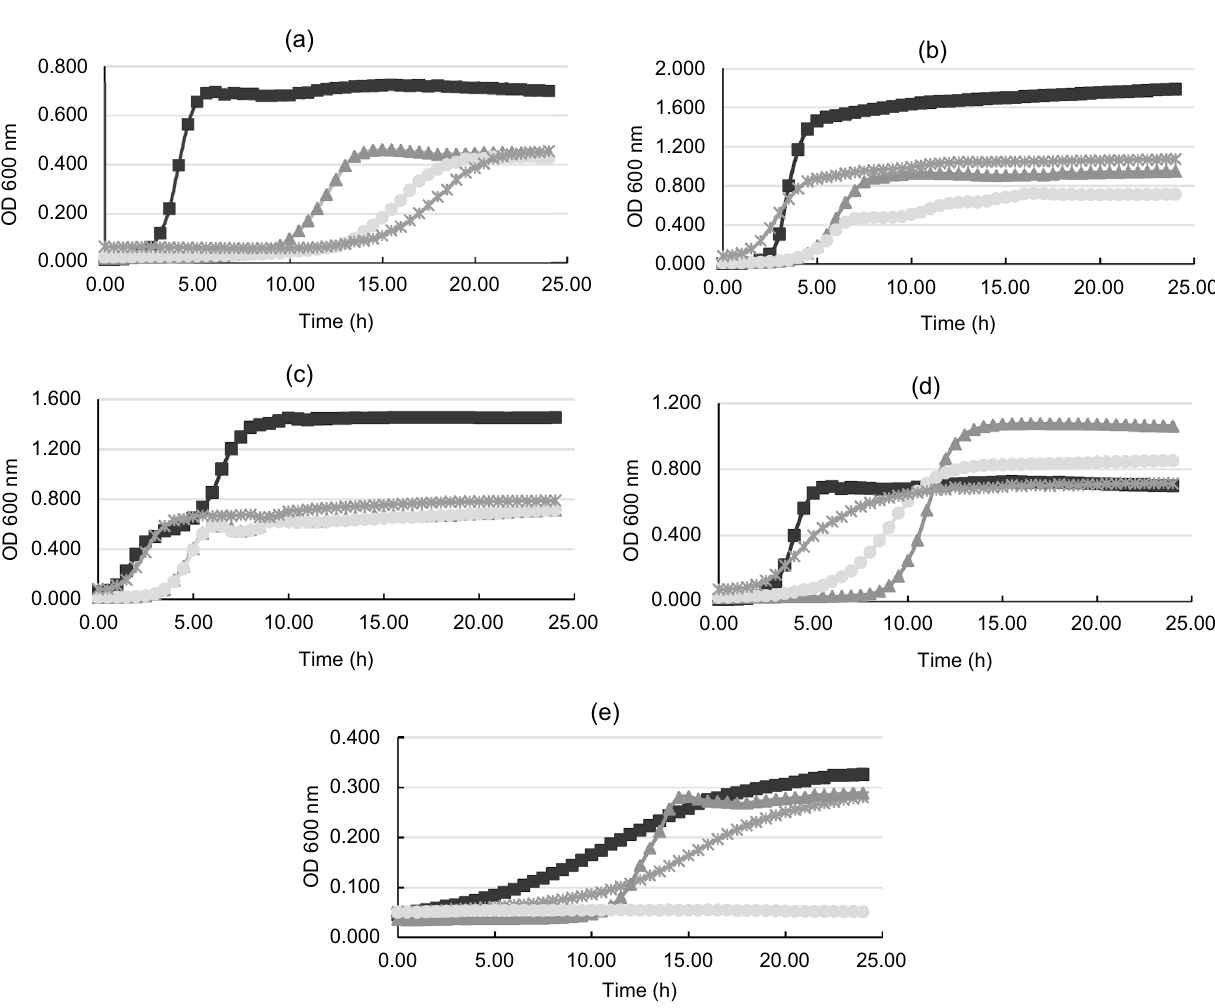
Figure 4. Antimicrobial activity of BLIS produced by L1 (filled black triangle), L2 (filled gray circle), and EF (cross symbol) against the pathogens L. monocytogenes ( a ), S. Choleraesnius ( b ), S. Typhimurium ( c ), S. aureus ( d ), and S. agalactae ( e ). Assays performed with positive controls (filled black square). The results are represented as an average of three